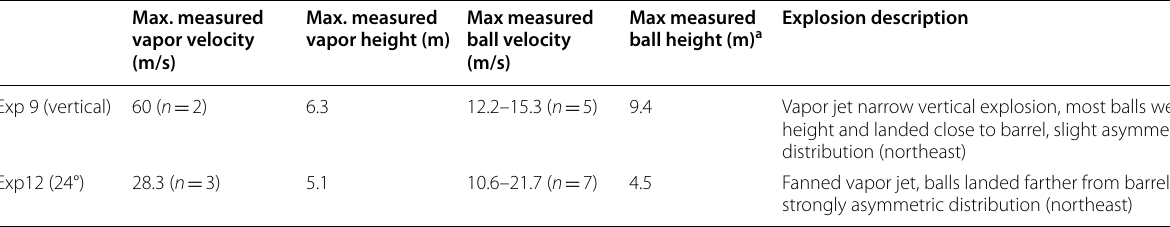
a Measured from base of explosion above